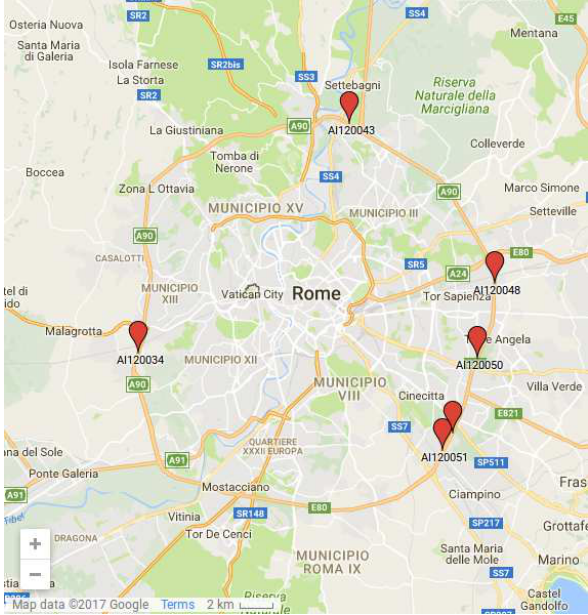
Figure 5: Recording campaign sites of the Rome suburban